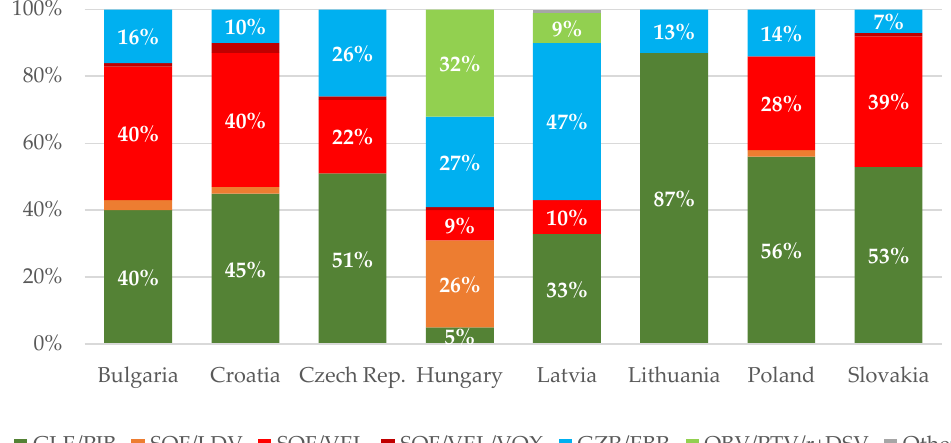
Figure 2. Proportions of patients treated in 2016–2021 by country.